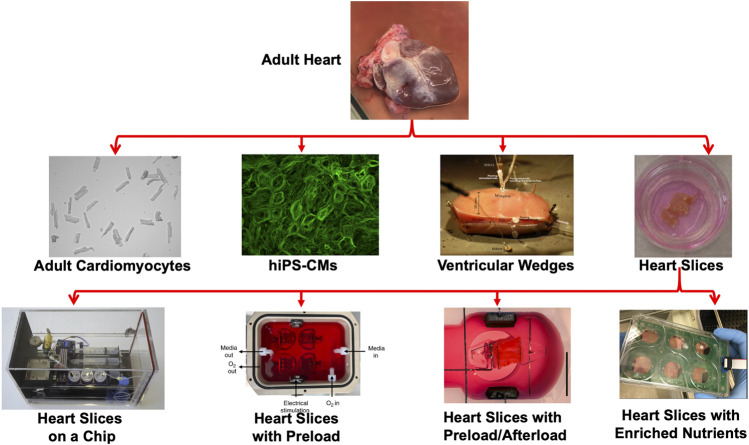
Modeling heart tissue in cultures. Representation of the various platforms used to model cardiac physiology in culture including adult cardiomyocytes (Mohamed et al., 2017), hiPS-CMs (Mohamed et al., 2018), Ventricular wedges (Di Diego et al., 2013) and heart slices (Brandenburger et al., 2012). Recently, several groups advanced the heart slice technology by developing heart slices on-a-chip (Qiao et al., 2019), including preload (Watson et al., 2019), including preload/afterload (Fischer et al., 2019), or enriching the culture medium with nutrients (Ou et al., 2019).